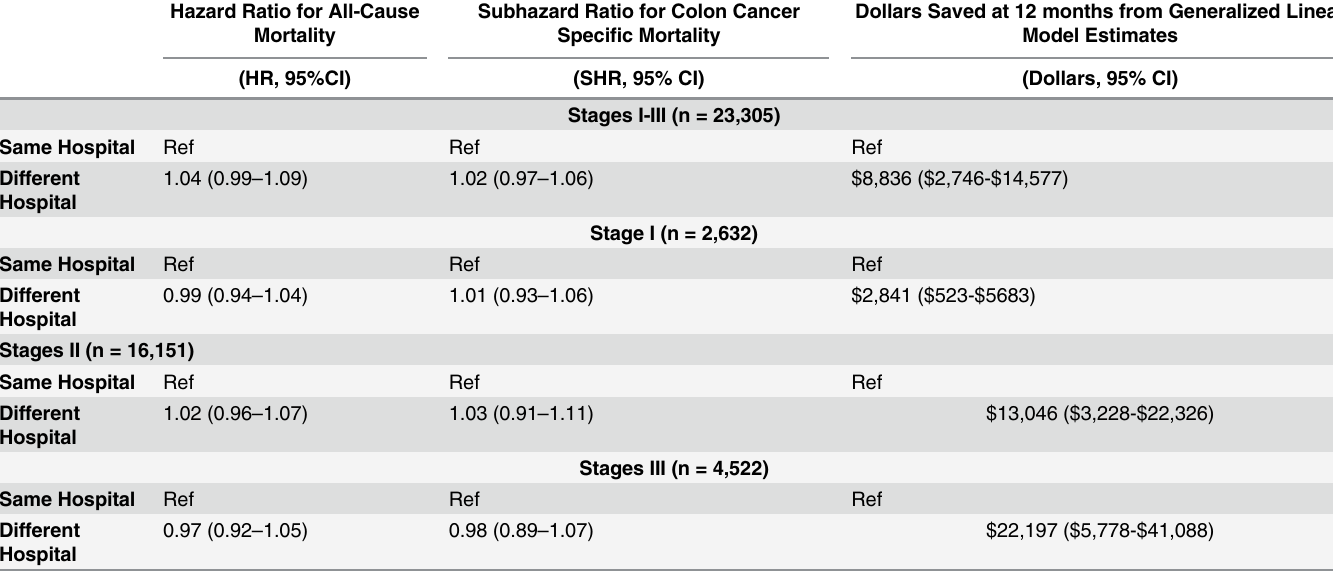
* : Estimates are fully adjusted for and have been matched on all patient, provider, and hospital characteristics listed in Table 2, as well as diagnosis year and SEER